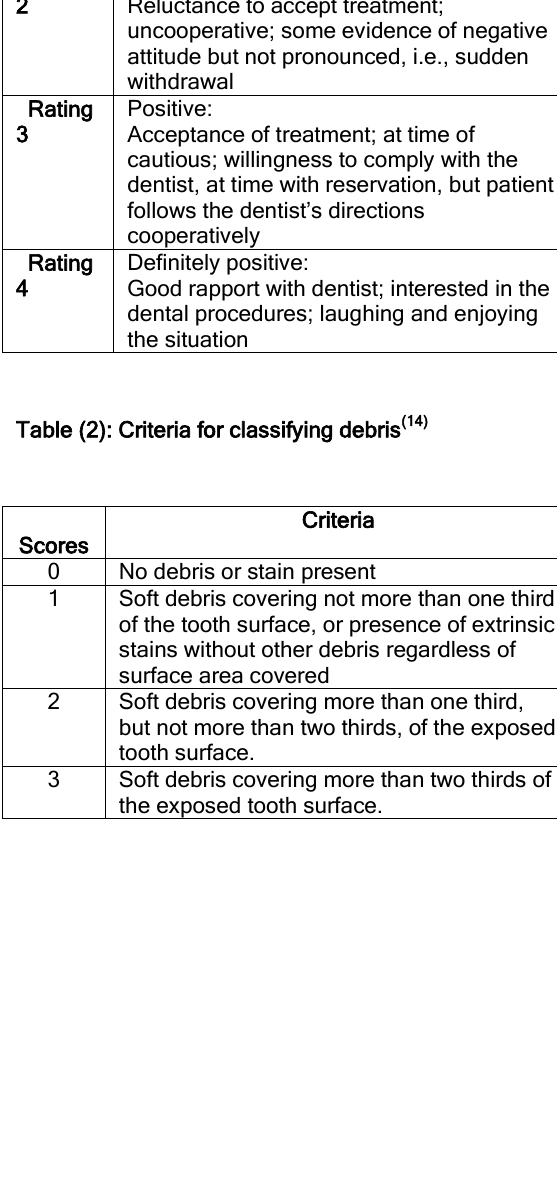
Table (4) Demonstrated the behavior of Autistic Children